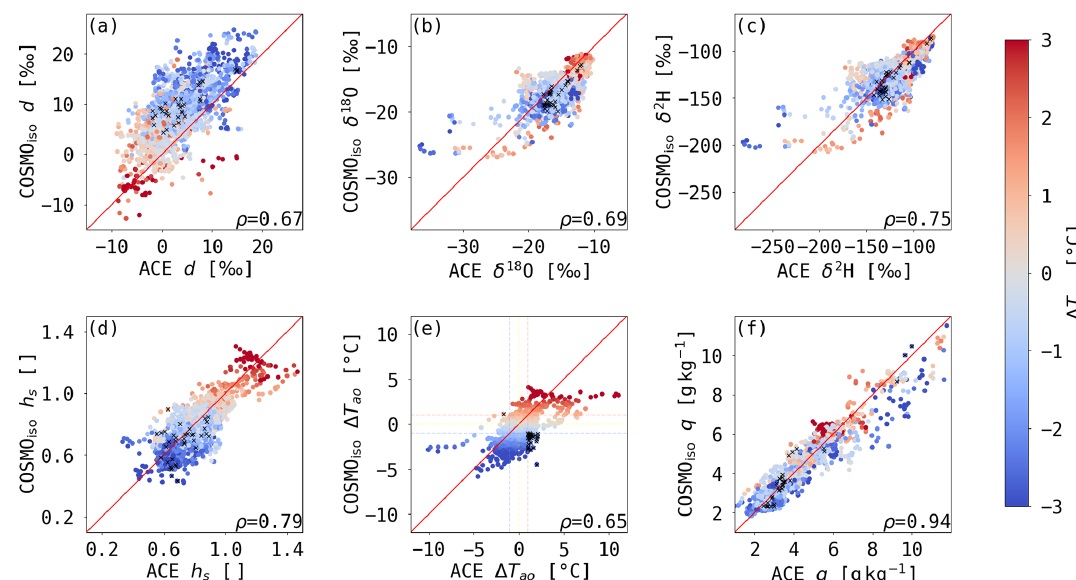
Figure 7. Scatterplots of 1-hourly ACE measurements vs. interpolated values from COSMO iso simulations at the lowest model level along the ACE ship track of (a) d , (b) δ 18 O, (c) δ 2 H, (d) h s , (e) air–sea temperature difference (cid:49)T ao and (f) specific humidity q coloured by (cid:49)T ao from COSMO iso . Points with contradicting cold and warm temperature advection classification between the measurements and simulations are marked with black crosses. The value of the Pearson correlation coefficient ρ for each variable is shown in the bottom right of the panels.